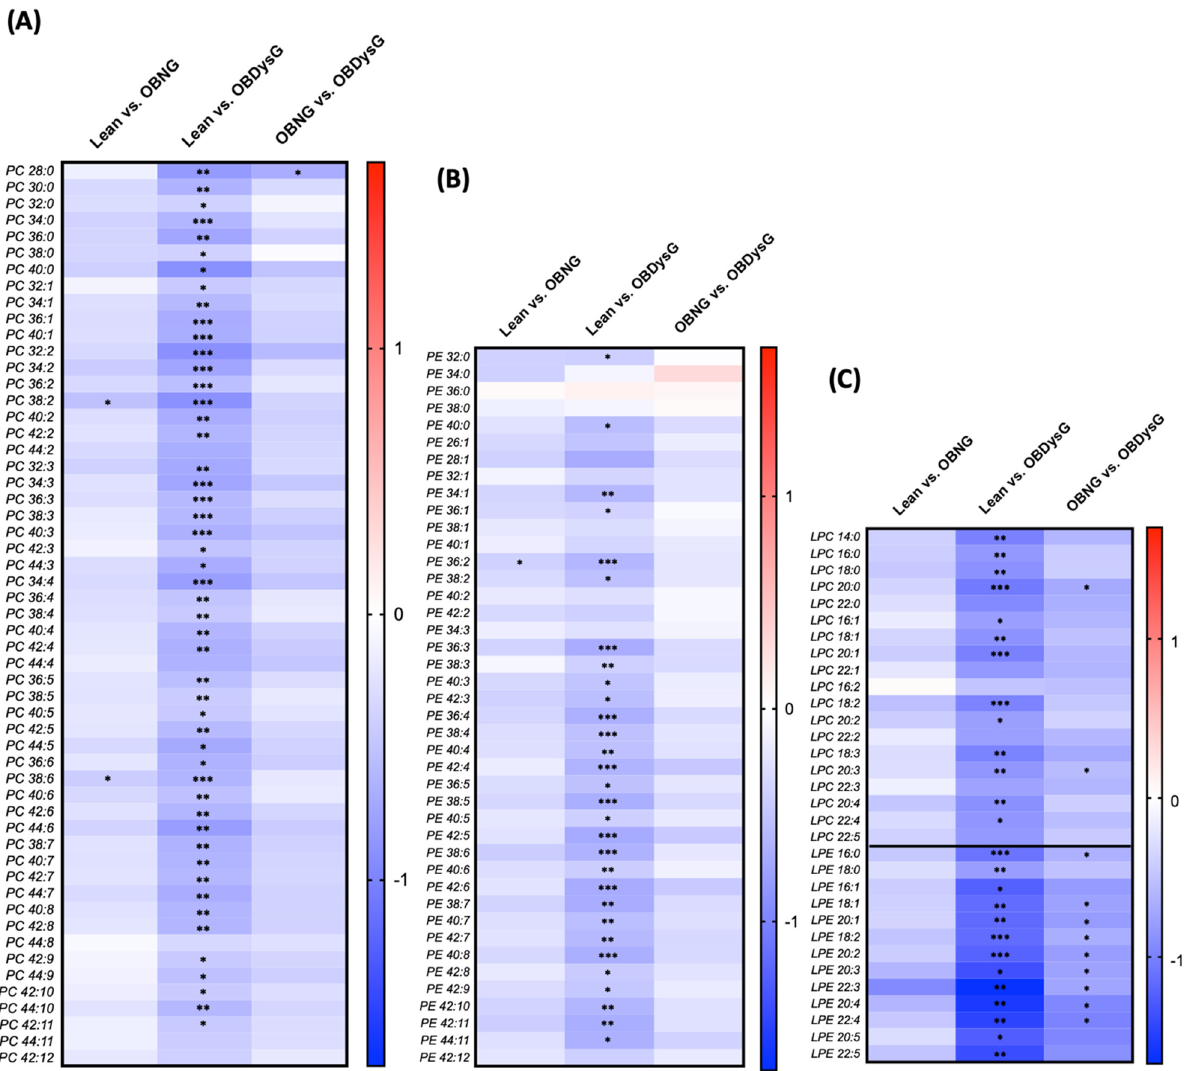
Figure 2. Log2FC of all ( A ) PC, ( B ) PE and ( C ) Lyso-PC/-PE lipid species detected in PBMCs between lean and OBNG or OBDysG patients and between the two obesity phenotypes (OBNG vs. OBDysG). Mean comparison * p ≤ 0.05; ** p ≤ 0.01; *** p ≤ 0.001. Kruskal-Wallis followed by Dunn post hoc test was performed on data.